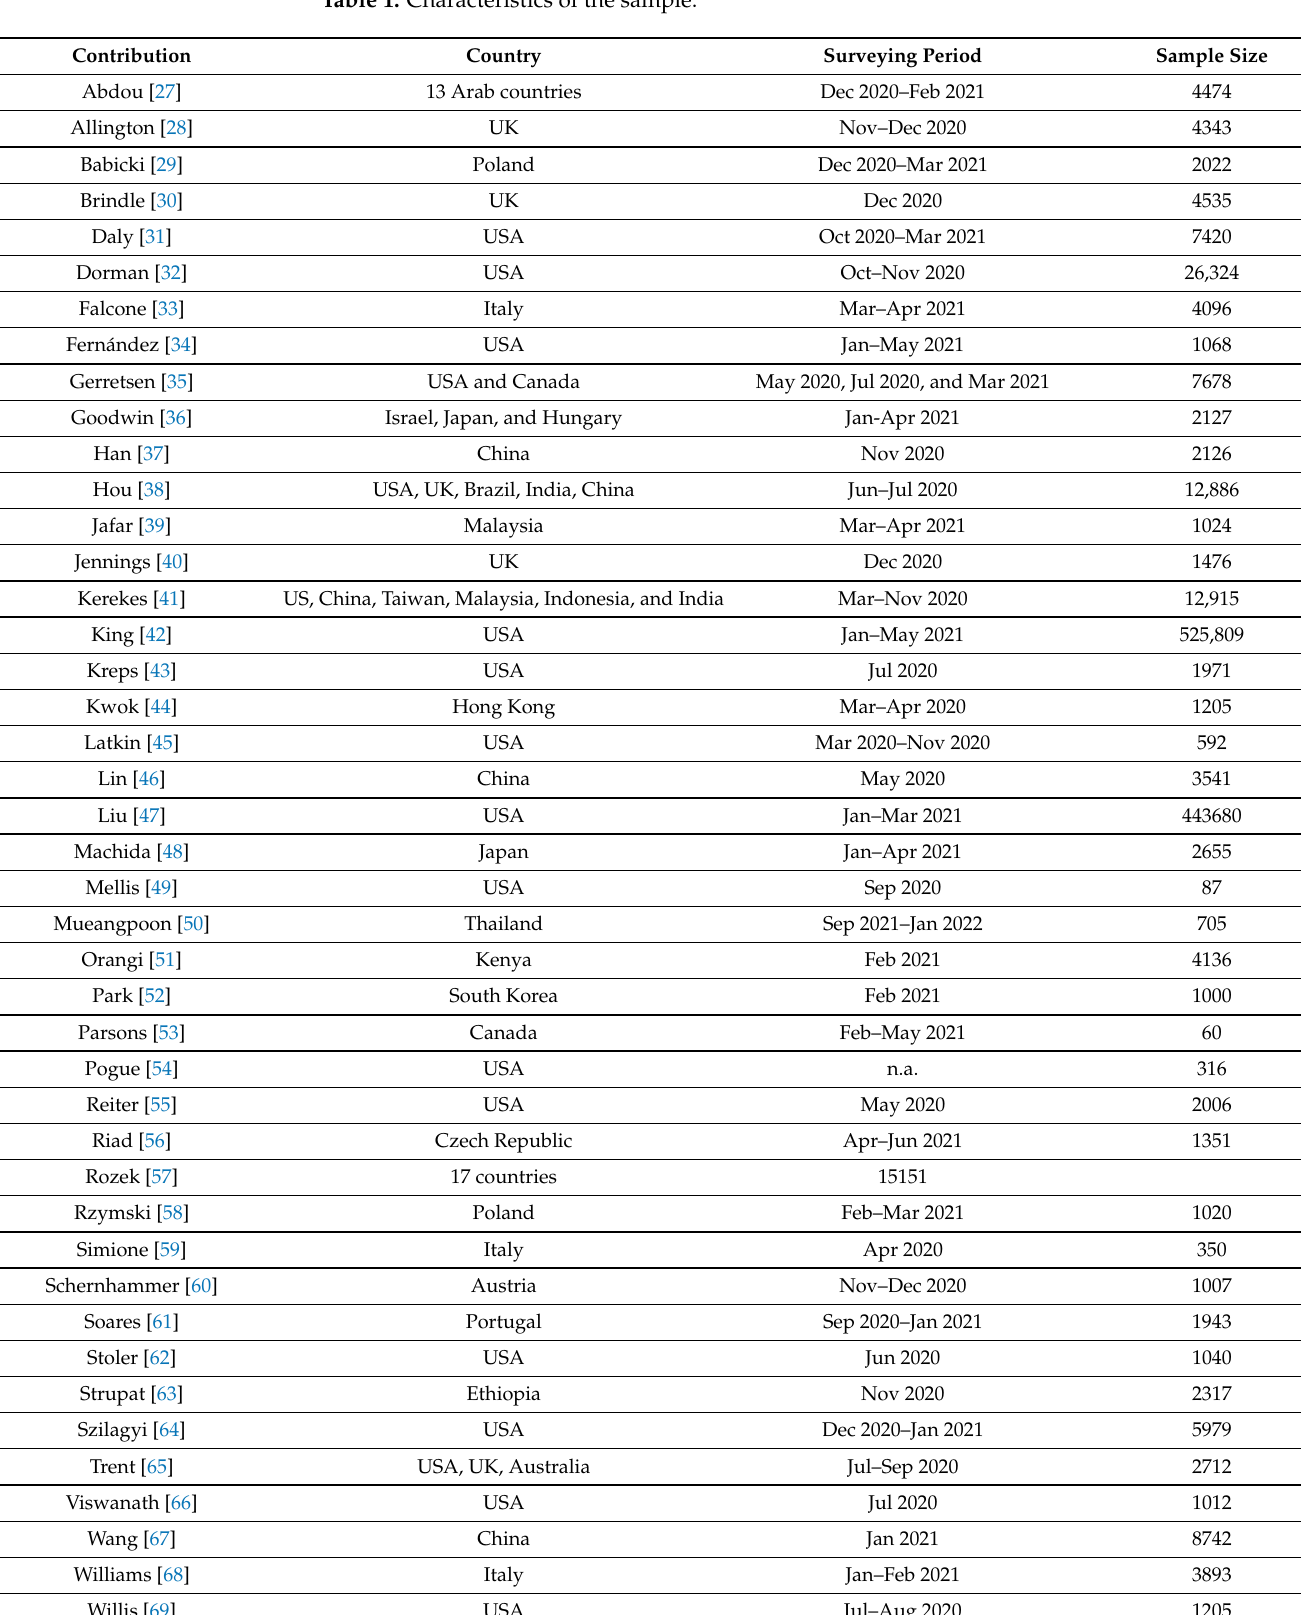
Table 1. Characteristics of the